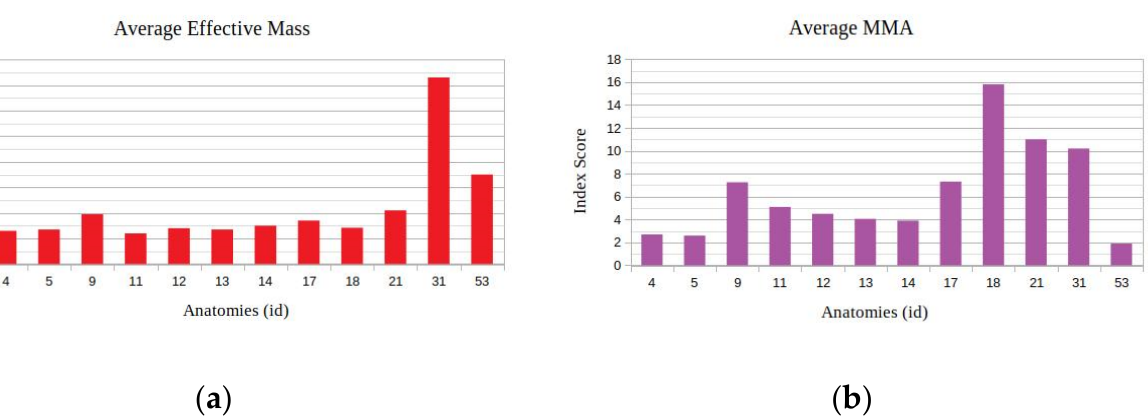
Figure 19. Derived mean index value for the selected performance indices under the available metamorphic structure anatomies, for Task 3 (( a ) with respect to the Average Effective mass index, ( b ) with respect to the Average MMA index).